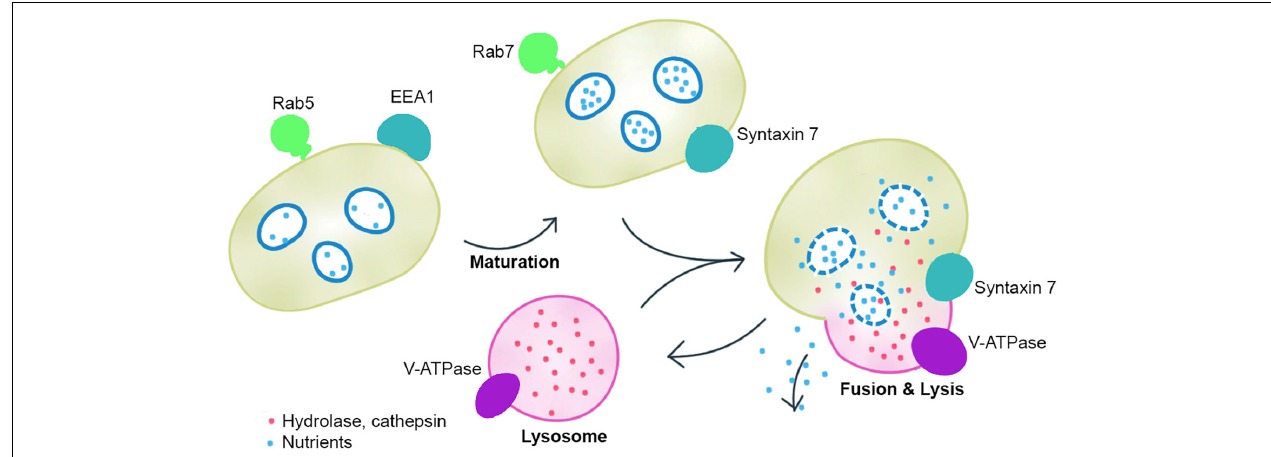
FIGURE 5 | A working model showing the function of the highly expressed genes. Early endosome antigen 1 (EEA1) and Rab5 first promote the fusion between Rab5-positive vesicles and their maturation into Rab7-positive vesicles; Rab7 enhances the fusion between mature symbiont-containing vesicles and promotes their further maturation for fusion with lysosome; Syntaxin 7 is required for the fusion between Rab7-positive vesicles and lysosomes; and lastly V-type proton ATPase subunit C 1A-like protein, lysosomal hydrolases, and cathepsin proteins in the lysosomes support the host in carrying out the vigorous lysosome activity to digest the symbiont. The model indicates that the hosts have developed sophisticated mechanisms to efficiently digest the endosymbiont